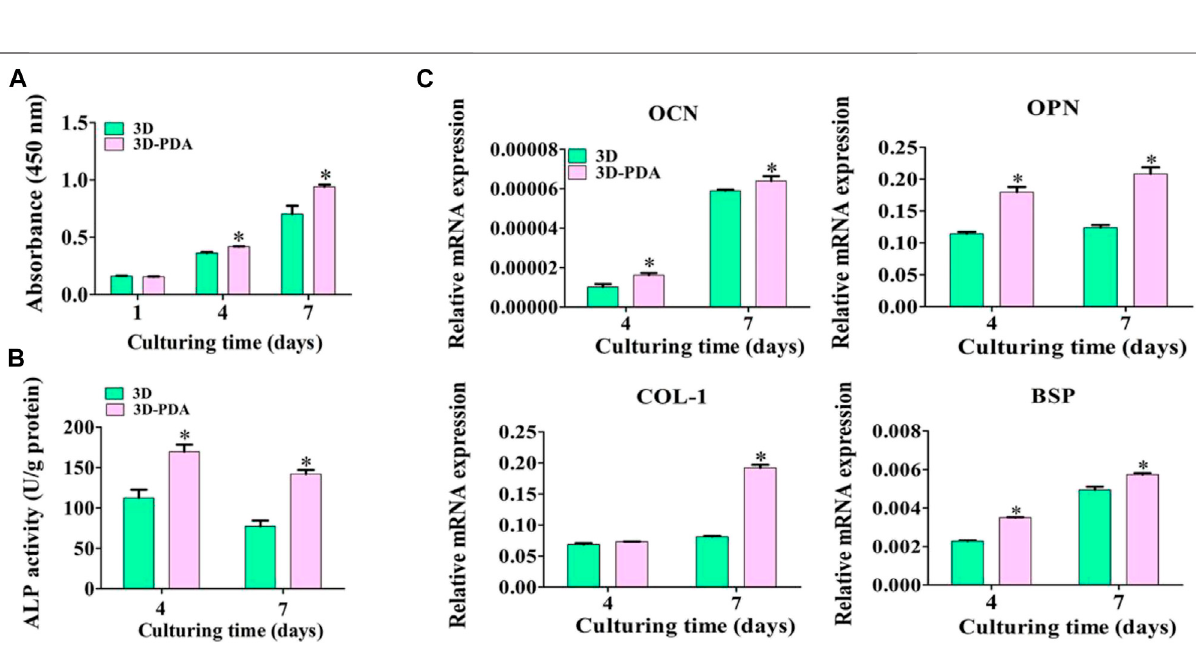
Frontiers in Bioengineering and Biotechnology |